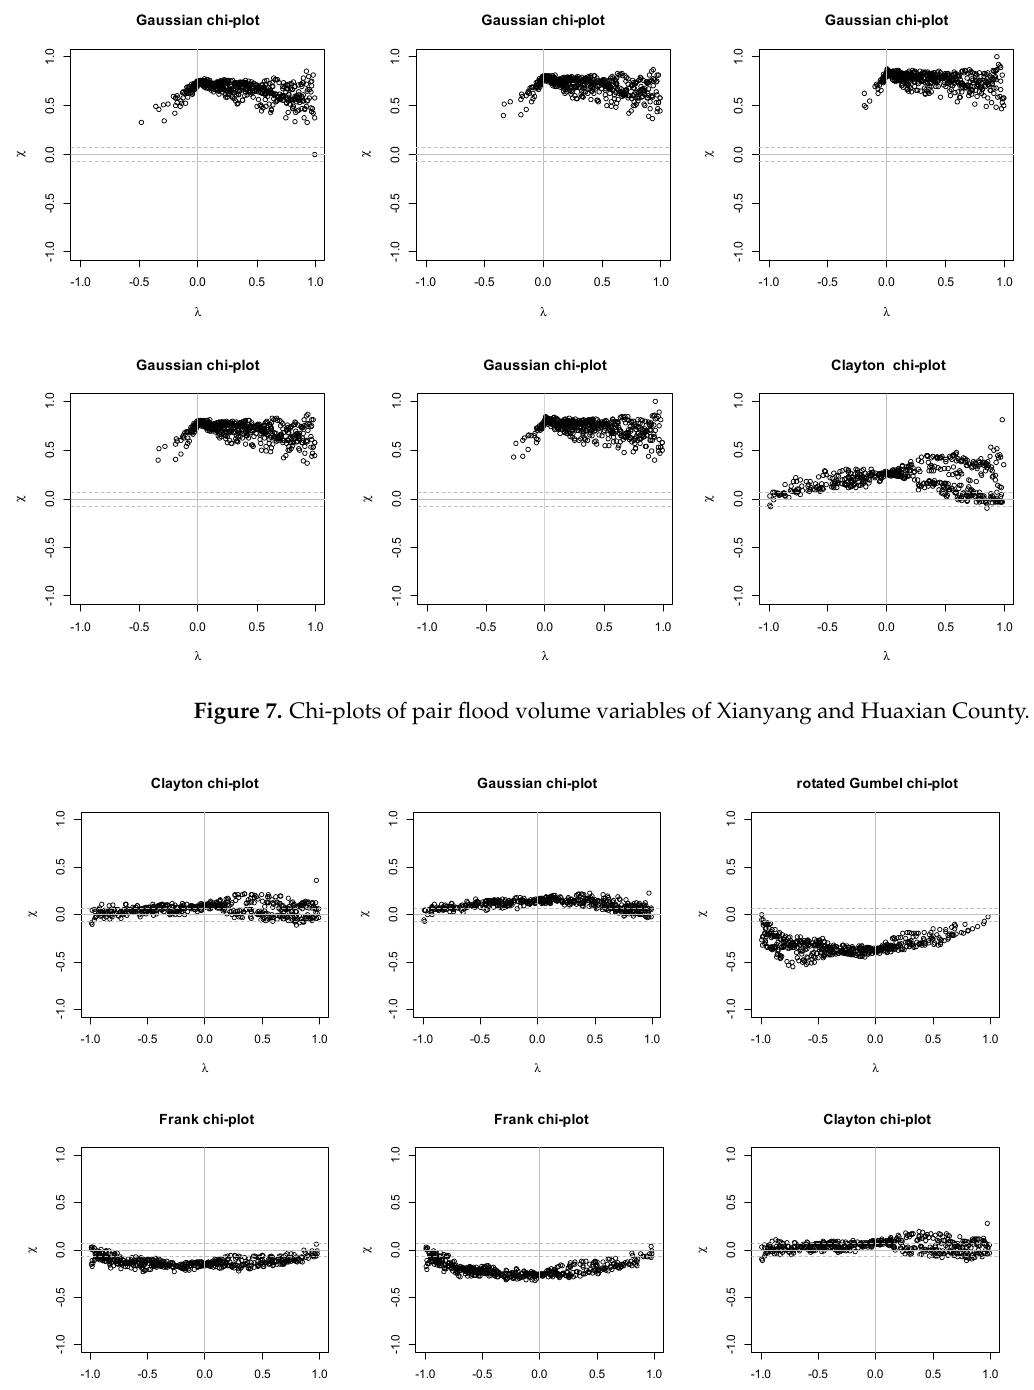
Figure 6. Chi-plots of pair flood volume variables of Zhangjiashan and Xianyang.